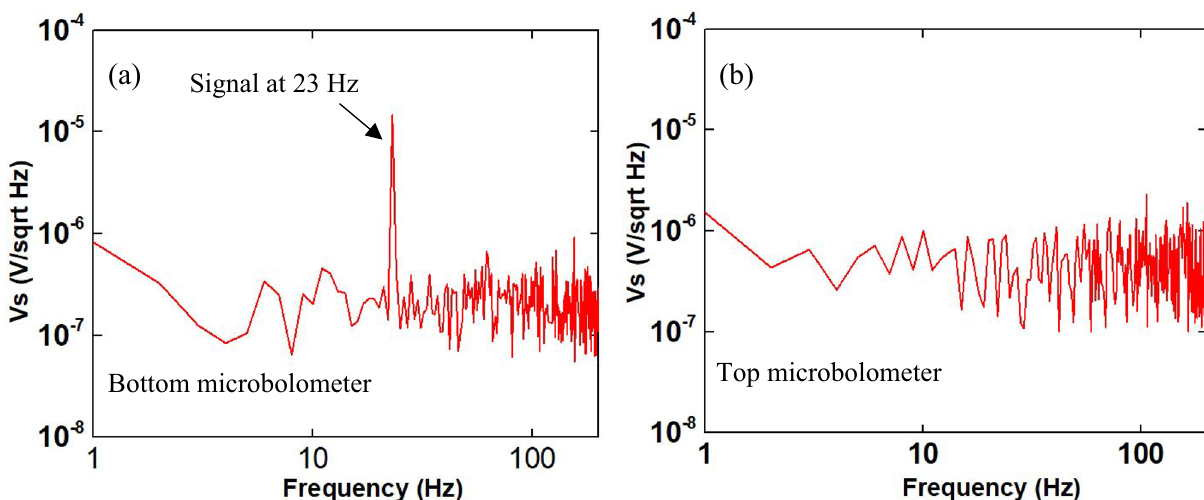
Figure 6. A typical voltage spectrum measured in vacuum at a bias current of 320 nA in response to a Blackbody light source chopped at 23 Hz at and wavelength of 10.3 µm illuminated the detector with d = 1.64, p =